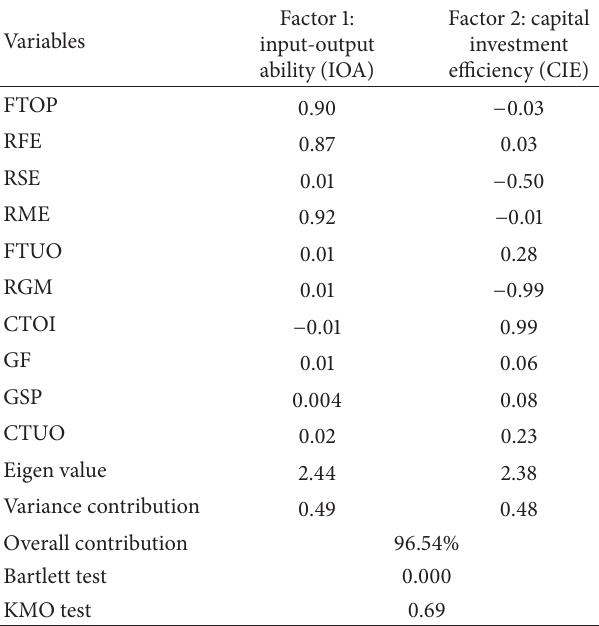
Table 2: Factor analysis